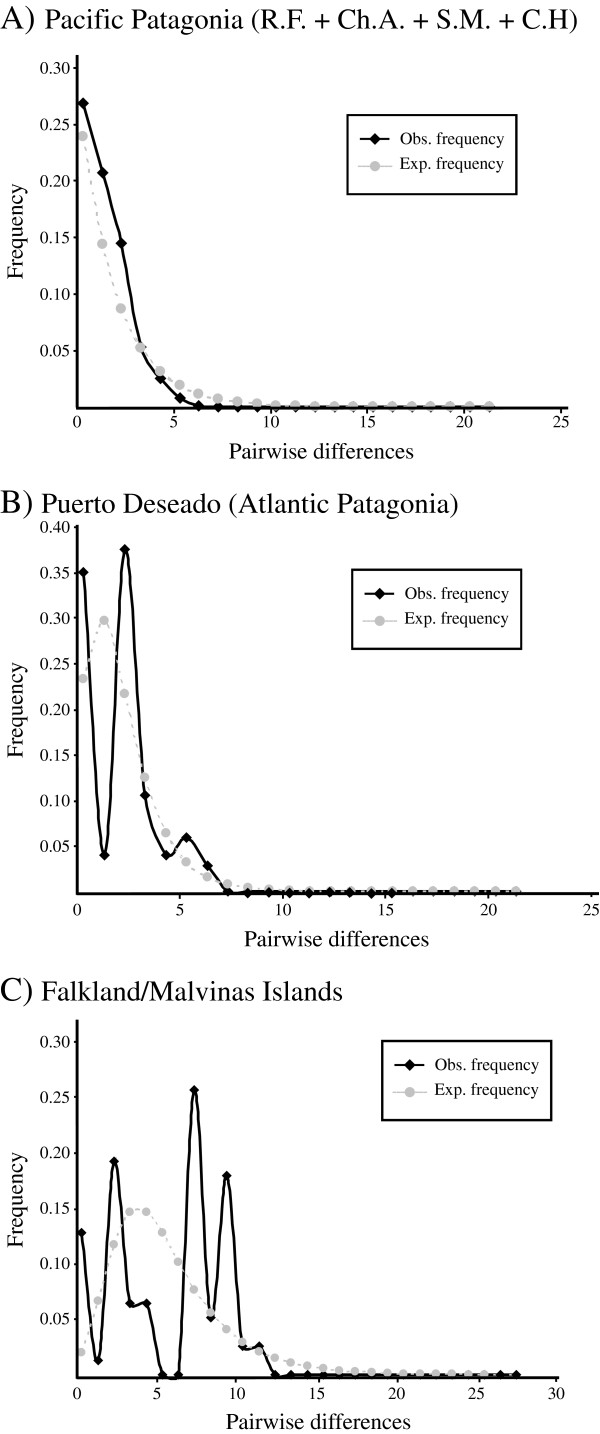
Pairwise difference distribution (mismatch distribution) for the Cytochrome c oxidase subunit I (COI) in N. magellanica in different areas of Patagonia.A) Pacific Patagonia; B) Puerto Deseado; C) Falkland/Malvinas Islands. R.F.=Reloncaví Fjord; Ch.A.=Chonos Archipelago; S.M. Strait of Magellan; C.H. Cape Horn.